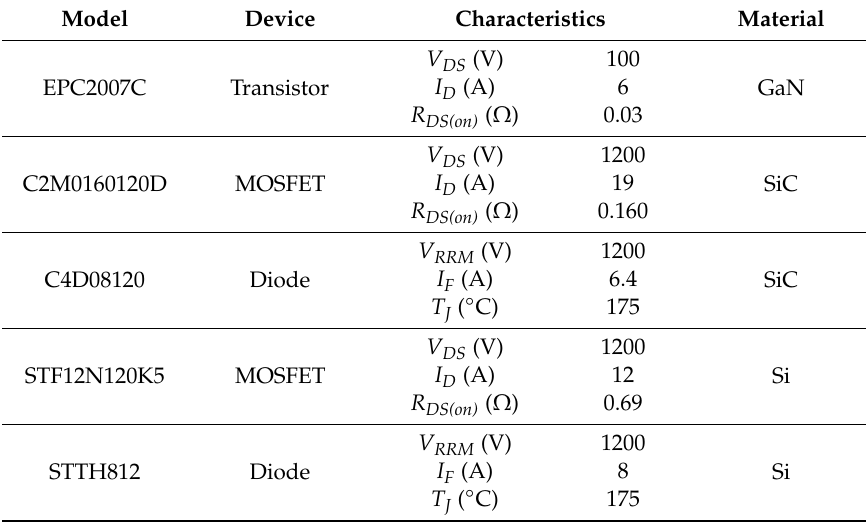
Table 4. Characteristics of the power semiconductor devices.